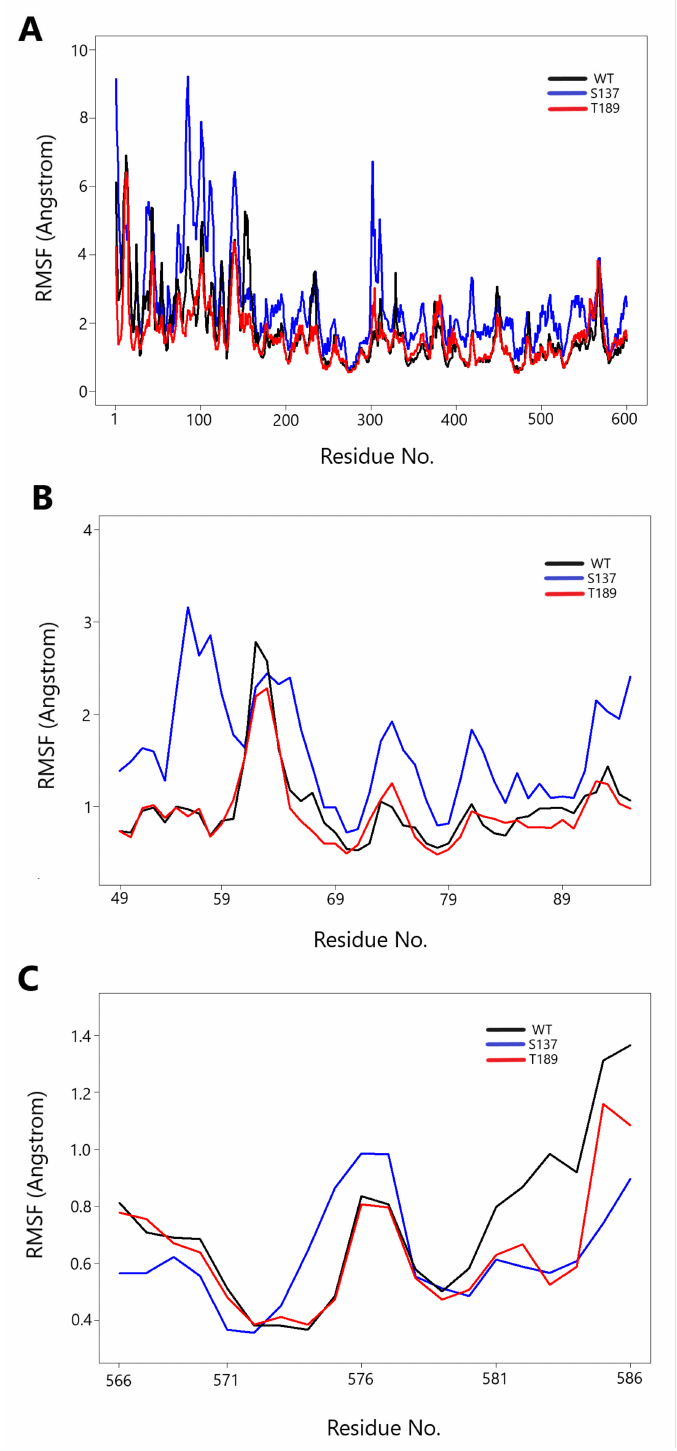
Figure 5. Root mean square fluctuation (RMSF) vs. MD simulation for the three simulated NS3 structures. Phosphorylation at serine 137 (S137) increases NS3 protein all residues fluctuation. ( A ) The RMSF of three simulated NS3 “all” amino acid residues throughout the MD simulation compared to the starting structure (unphosphorylated WT at time 0 ns). The WT is shown in “black,” S137 is in “blue,” and T189 is in “red”. ( B ) The RMSF of three simulated NS3 (residues 49–95) shows an evident rise in RMSF value in S137 residues (40–50) compared to WT and T189. ( C ) The RMSF of three simulated NS3 (residues 566–586) shows a close pattern of the three simulated